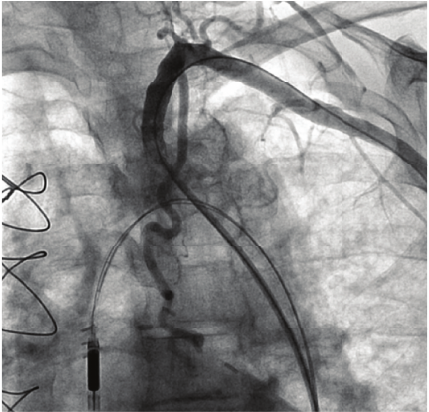
Figure 4: Critical ostial subclavian artery stenosis.